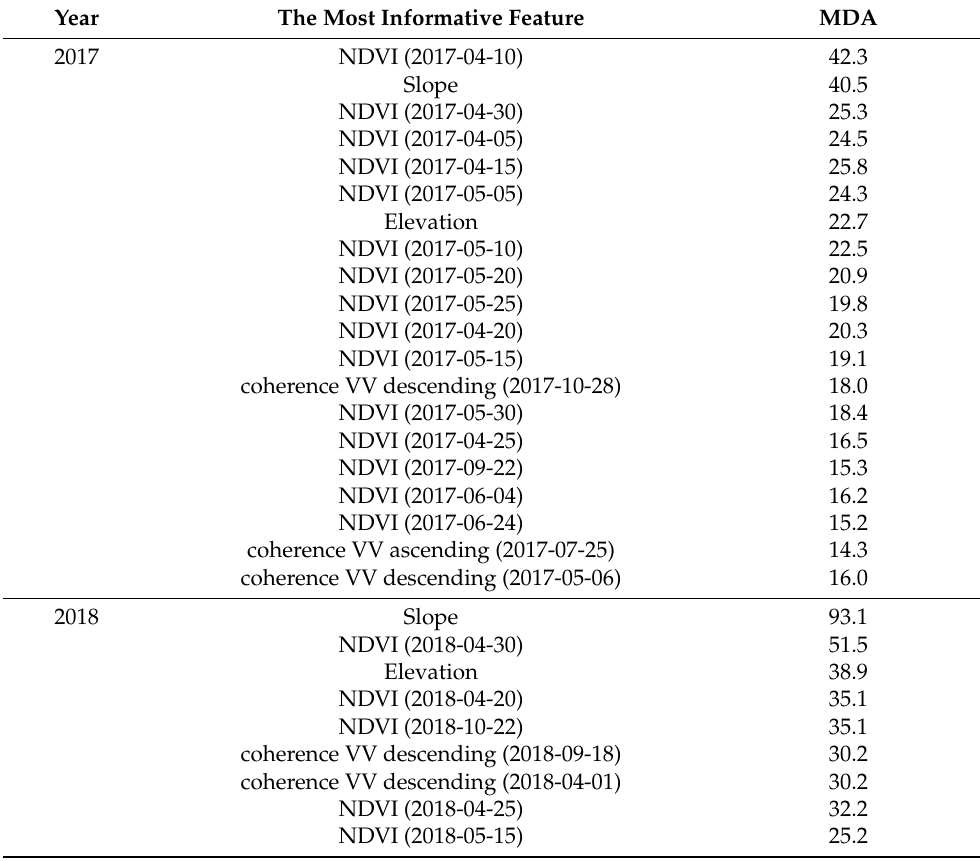
Table 4. RF model with the most important features for the analysed years. The last column indicates the value of the Mean Decrease in Accuracy (MDA).